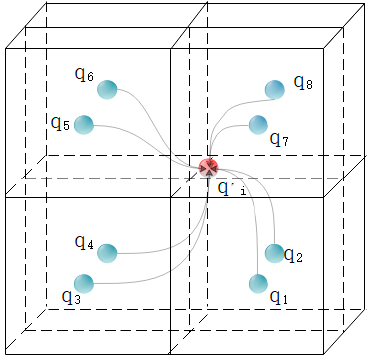
Figure 6. Virtual namesake point synthesis.